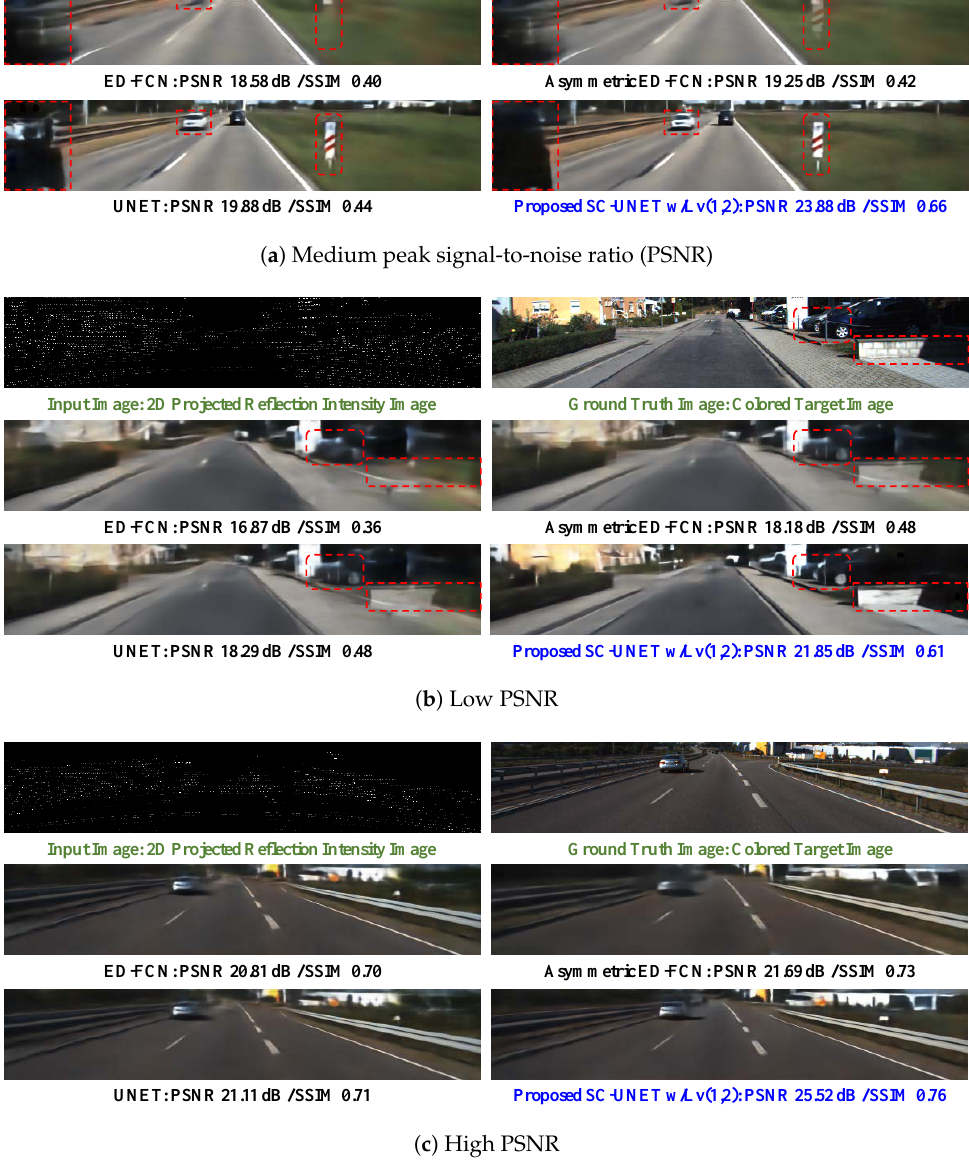
Figure 4. Sample inference